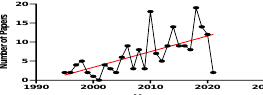
Figure 1. Number of Papers related to WM in Nairobi. (The red line is linear regression lines for the data